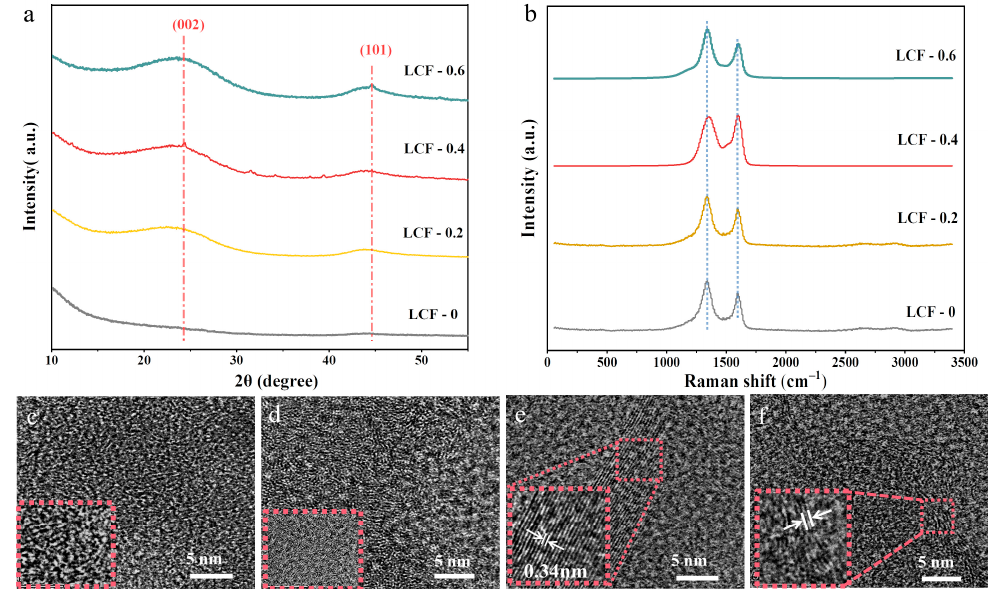
Figure 5. ( a ) Raman spectra, ( b ) XRD patterns, and ( c – f ) corresponding TEM images of LCFs with